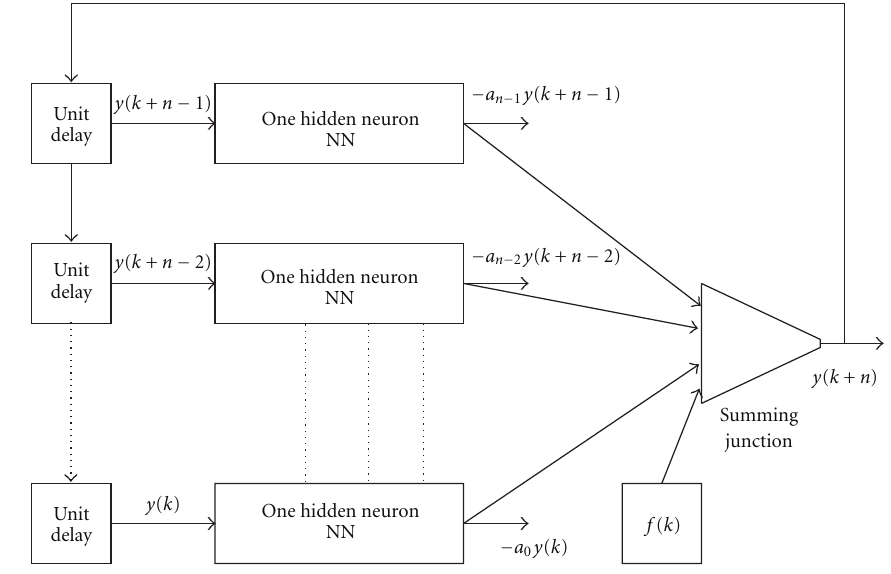
Figure 2: NN for modeling di ff erence equation.